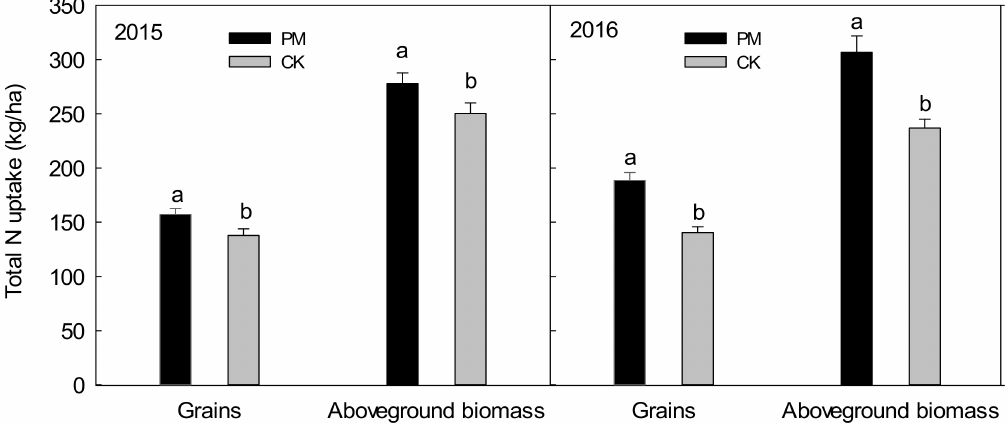
Figure 3. Total nitrogen uptake of the grain and the aboveground biomass under plastic mulching and non-mulching at harvest in 2015 and 2016, respectively. Means followed by different letters are significantly ( p < 0.05) different between film mulched and non-mulched. PM, maize mulched with plastic film; CK, maize without plastic